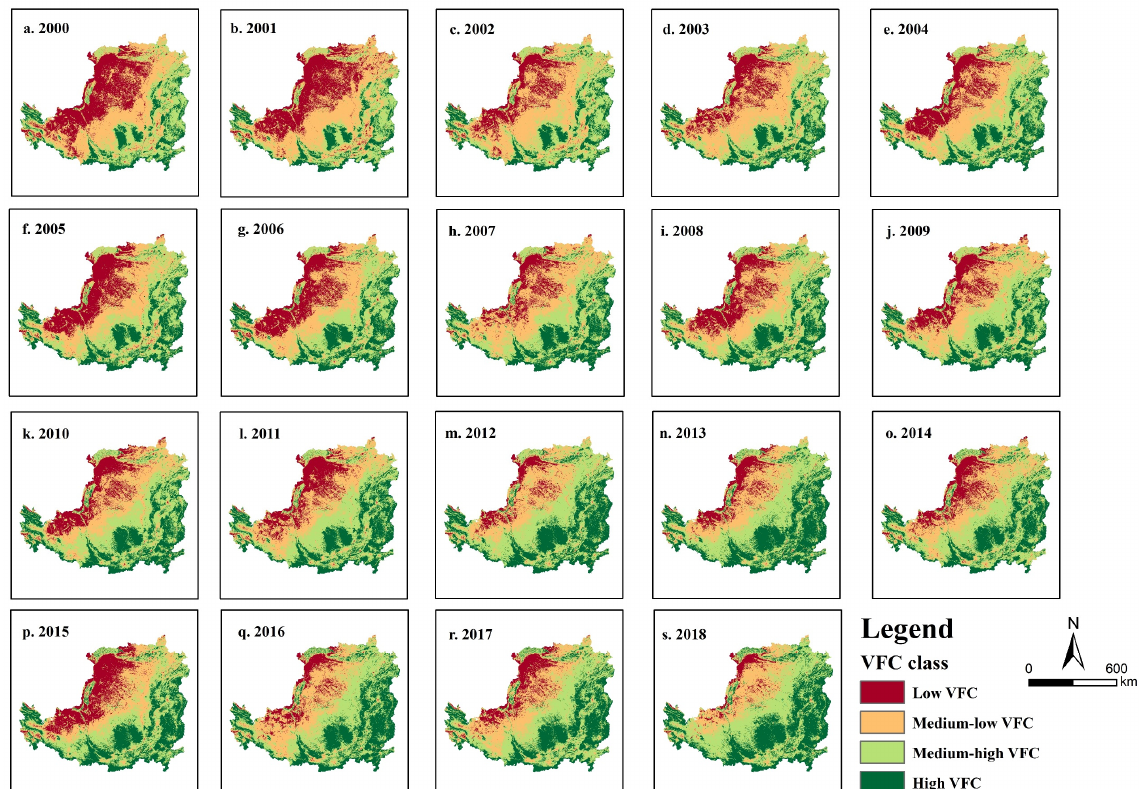
Figure 4. Spatial distribution of VFC in the Loess Plateau from 2000 to2018.